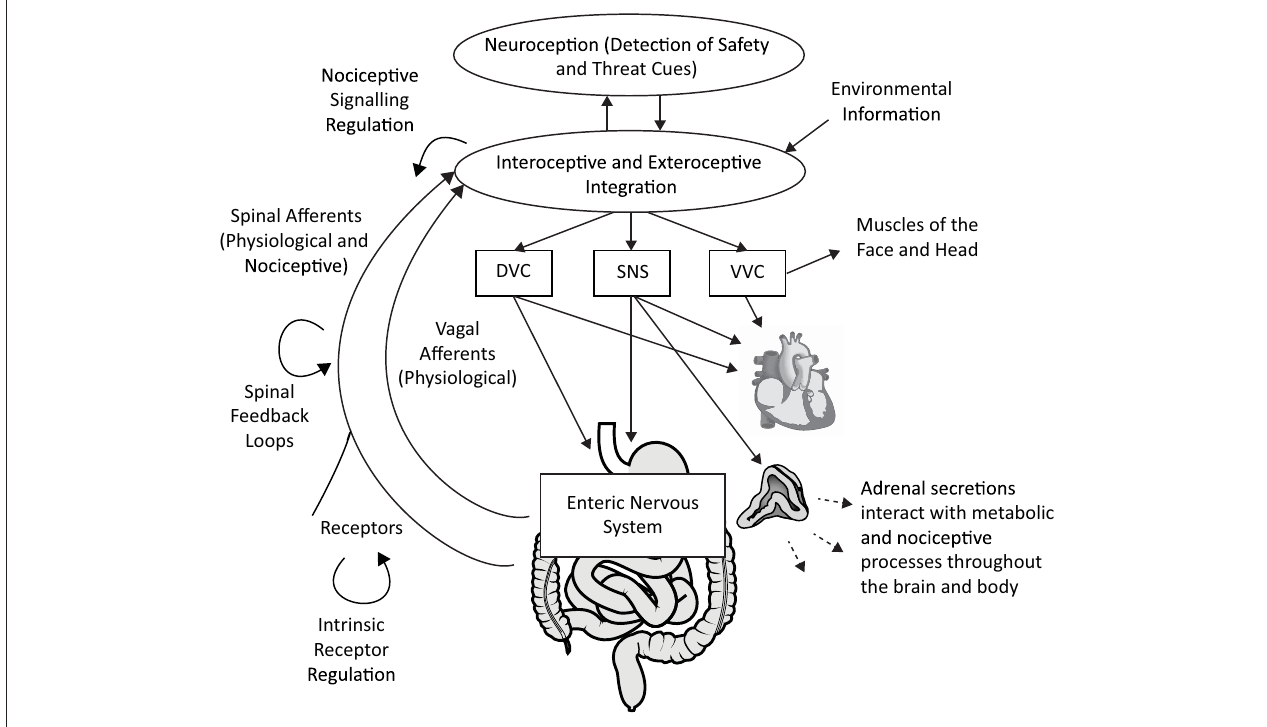
FIGURE 1 | A polyvagal perspective on autonomic regulation of nociceptive signaling and gastrointestinal function. Interoceptive and exteroceptive information is constantly monitored and interacts with neuroception, the non-conscious process of detecting safety and threat cues. These signals are used to regulate